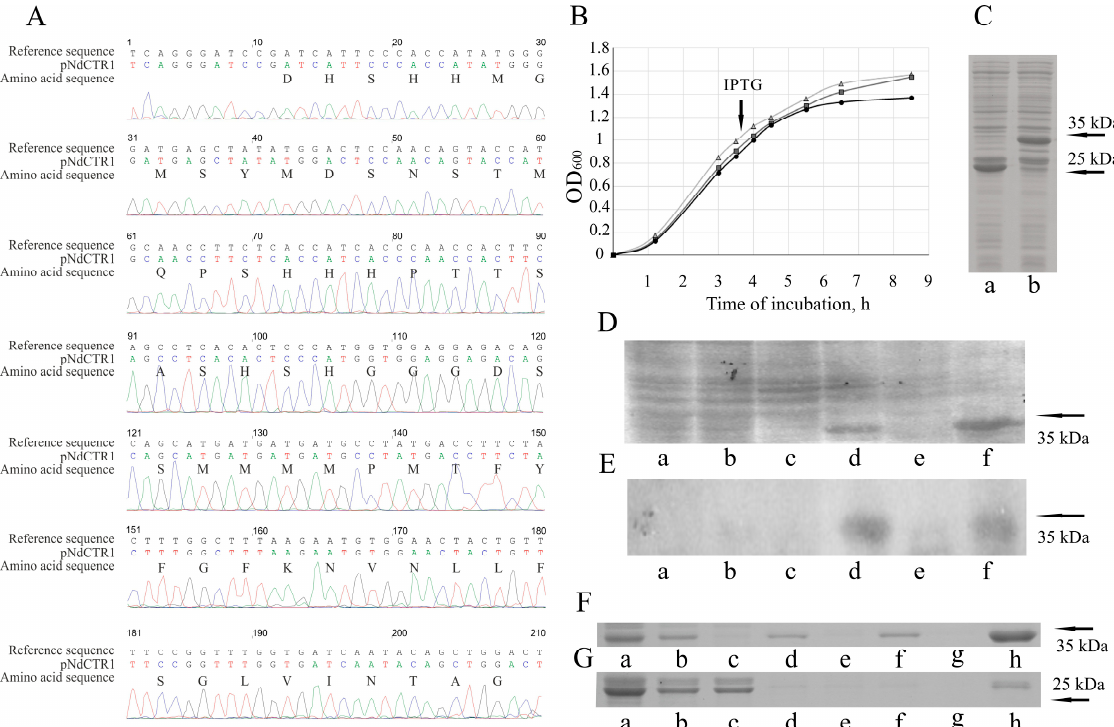
Figure 1. Cloning of ectodomain of human copper transporter 1 (hNdCTR1) and analysis of recombinant fusion protein. ( A ) The correspondence of the cloned nucleotide sequence to the region of the human CTR1 gene. ( B ) The growth rate of the control Escherichia coli strain and strains transformed with plasmids expressing either glutathione-S-transferase (GST) or GST-hNdCTR1. Cycles: E. coli BL21(DE3); triangles: E. coli BL21(DE3)/pGEX-4T-1; squares: E. coli BL21(DE3)/pNdCTR1. ( C ) PAG-SDS electrophoresis of crude cellular extracts from E. coli BL21(DE3)/pGEX-4T-1 (lane a) and E. coli BL21(DE3)/pNdCTR1 (lane b) after incubation with isopropyl- β - D -thiogalactoside (IPTG) for 3.5 h. ( D ) PAG-SDS electrophoresis and ( E ) immunoblotting with antibodies to CTR1 of crude cellular extracts from E. coli BL21(DE3)/pNdCTR1 after incubation for 0, 1.5, and 3.5 h. Lanes a, b, c: total protein extract of non-induced culture; lanes d, e, f: total protein extract of IPTG induced culture. ( F , G ) PAG-SDS electrophoretic analysis of subcellular fractions from E. coli cells transformed with pNdCTR1 and pGEX-4T-1, respectively: cell crude extract (a), cell lysate after ultrasound treatment (b), soluble fraction of lysate obtained by centrifugation for 15 min at 16,000 g (c). Insoluble fraction of pellet was 3 times treated with solution containing 1% Triton X-100, 5 mM DTT and 2 M urea. After each treatment, soluble and insoluble fractions were separated by centrifugation for 15 min at 16,000 g . Consecutive pellets: d, f, h, and corresponding to them soluble fractions: e, g. arrows show molecular weights.